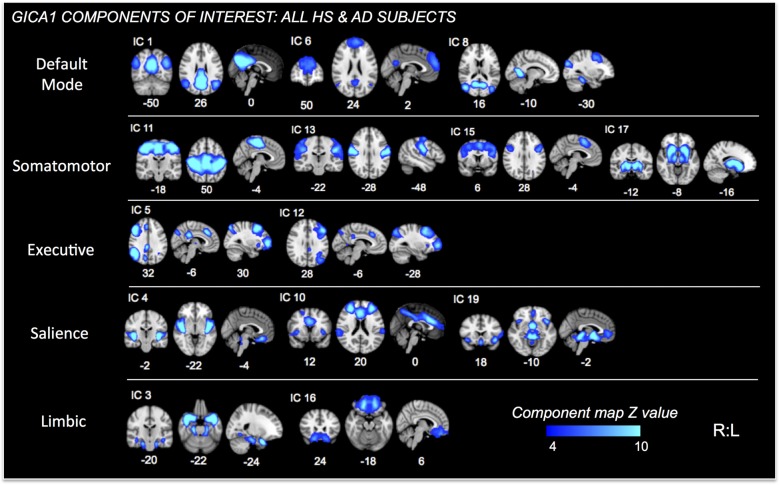
Independent Components (ICs) of interest resulting from Group ICA of all HS and AD subjects. These ICs were used in permutational tests exploring relationships between connectivity and PAINAD score differences between groups. ICs of interest determined via consideration of brain regions/networks typically associated with pain, emotion and behavior. Resultant ICs of non-interest, as well as those representing non-neuronal signal not shown. MNI coordinates (x, y, z) shown below each map.